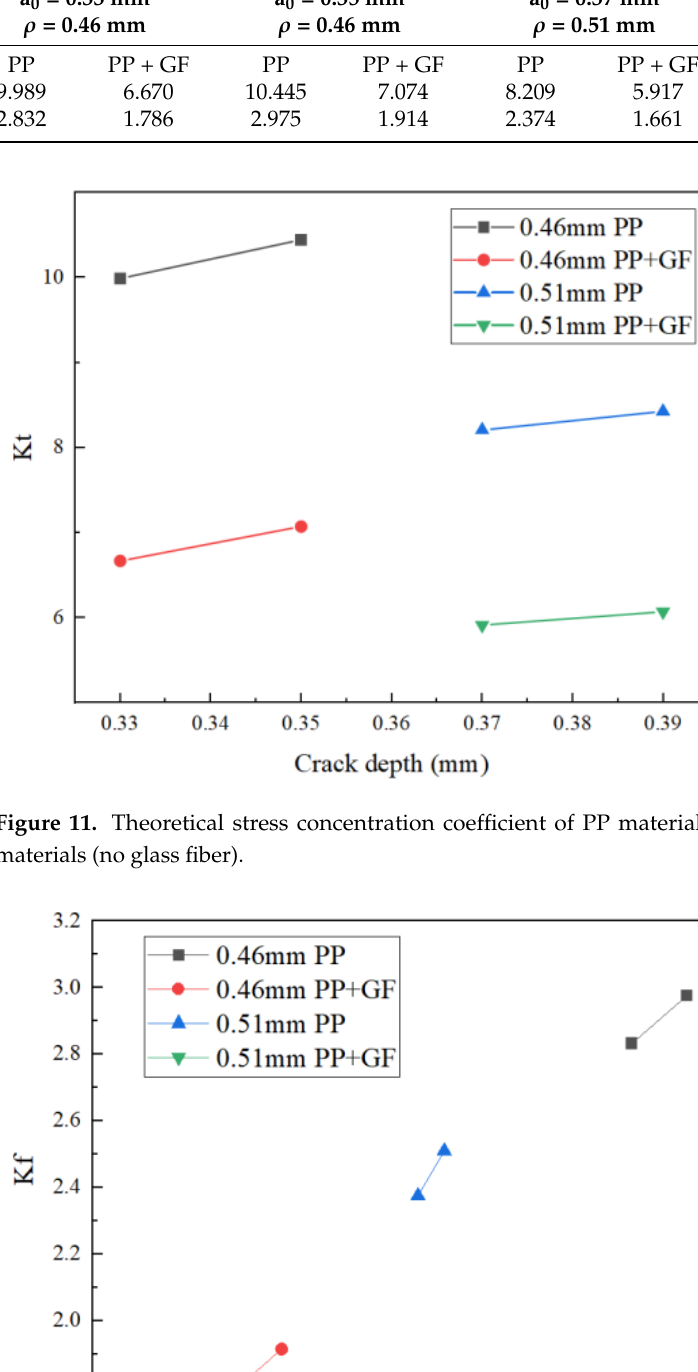
and 𝐾 relationship trend. 𝑡 𝑓